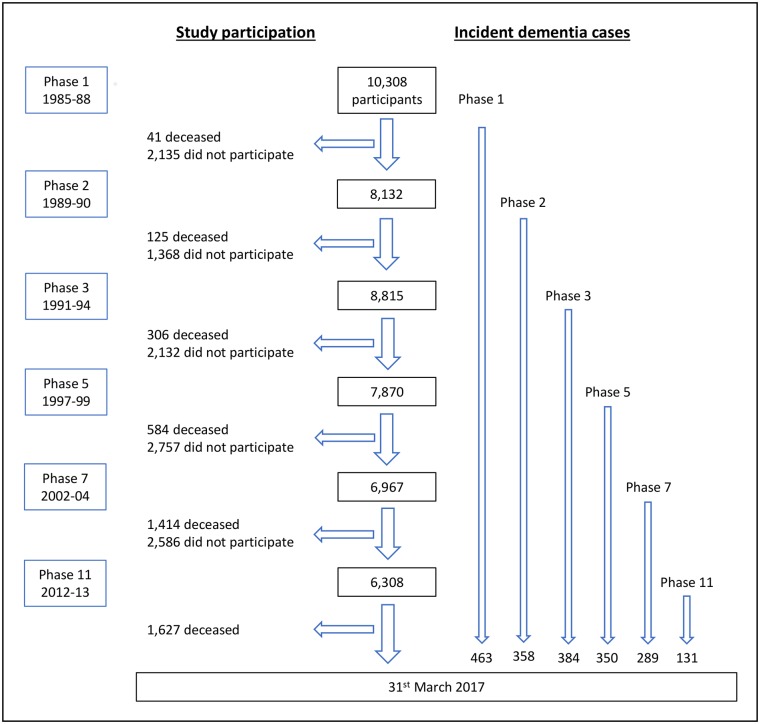
Flow chart of study participants.